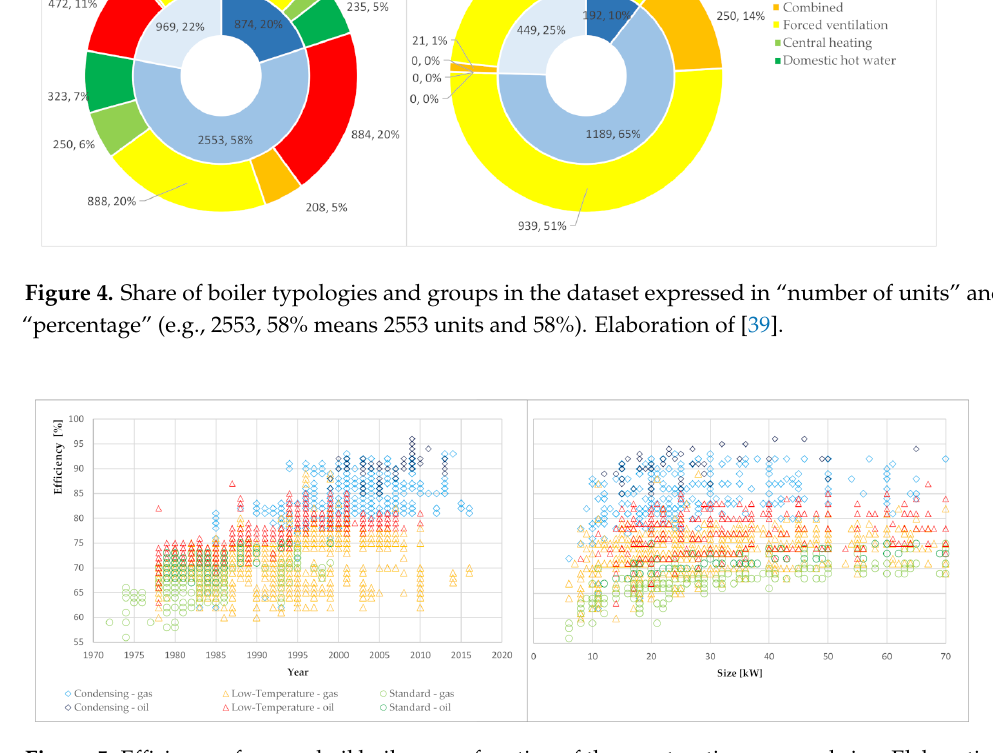
Figure 5. Efficiency of gas and oil boilers as a function of the construction year and size. Elaboration of [39].